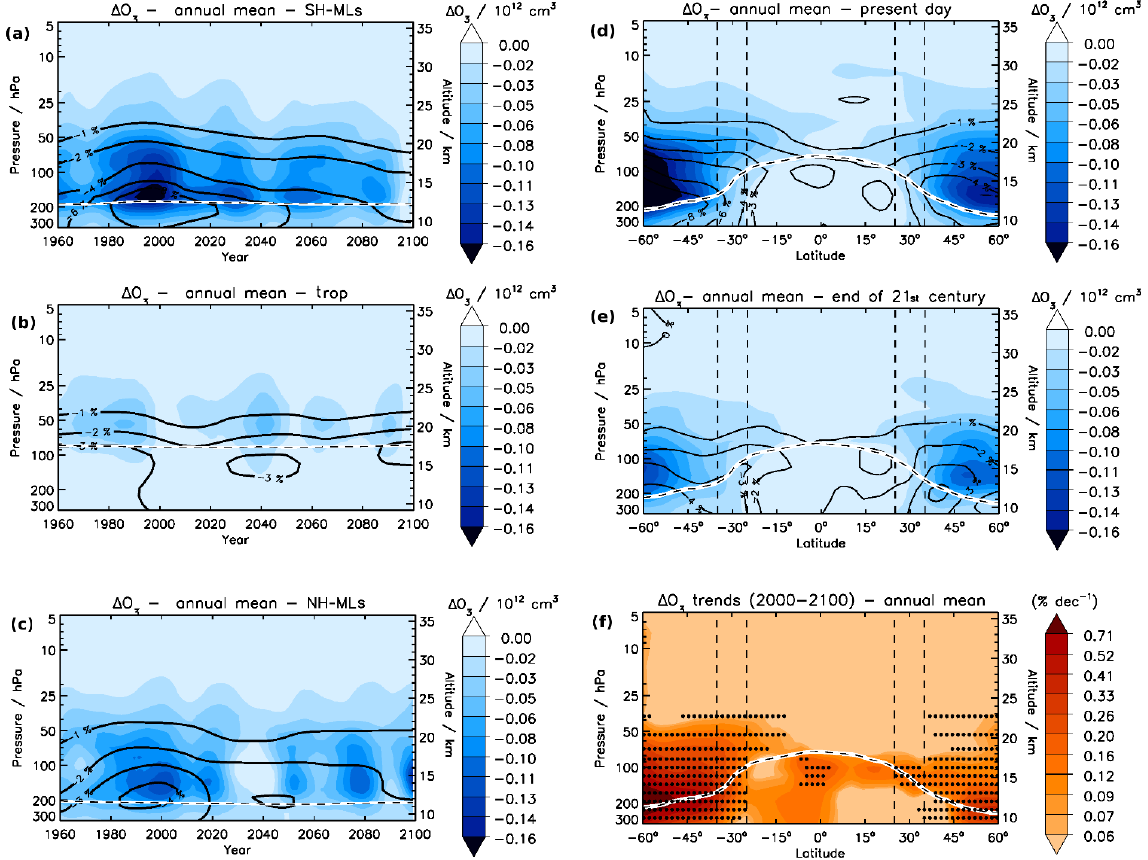
Figure 6. Temporal evolution of the annual mean ozone difference ( (cid:49) O 3 ) between experiments as a function of altitude (a) at SH-MLs, (b) in the tropics, and (c) at NH-MLs. The right panels show the zonal mean (cid:49) O 3 distributions for the (d) present day and (e) the end of the 21st century as well as the (f) (cid:49) O 3 trends (% per decade) over the century. The absolute (colour scale) and relative (contour line) ozone differences were calculated considering the ozone number densities (i.e. moleculescm − 3 ) of each experiment. The masked regions in panel (f) indicate where the relative (cid:49) O 3 (z) values between the present day and the end of the 21st century are statistically significant with a 95% confidence interval using a two-tailed Student’s t